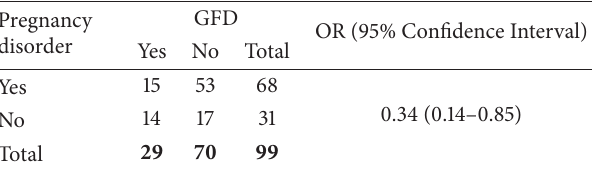
Table 4: Association between disorders in pregnancy and being on a GFD, Italy,